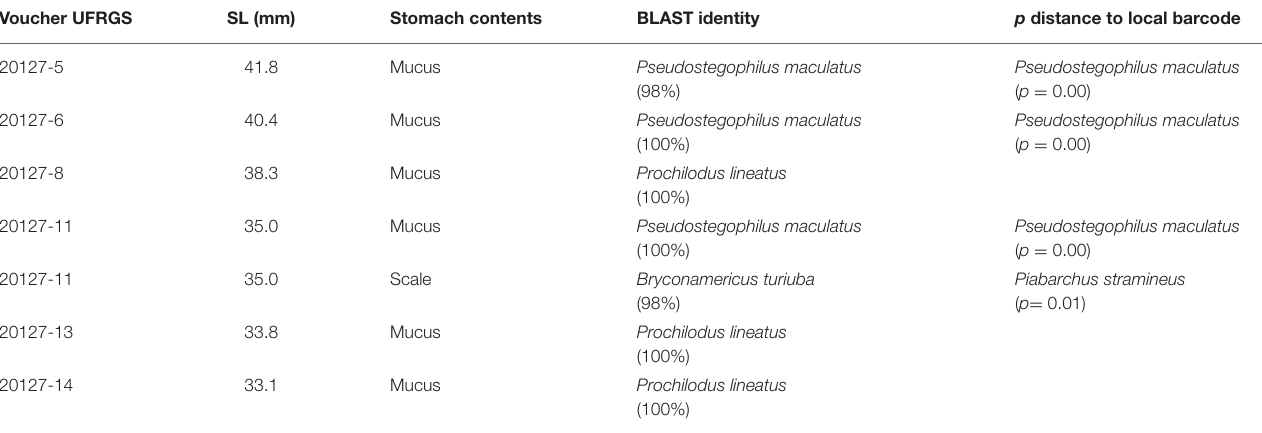
TABLE 2 | Results of the identification of the collected samples from stomach contents of Pseudostegophilus maculatus . Voucher